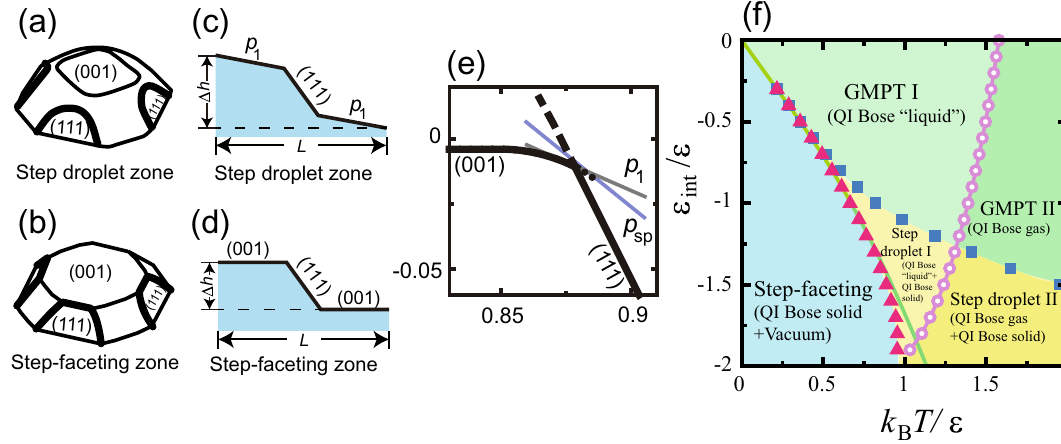
Figure 1. ( a ) and ( b ) Illustrations of perspective view of ECS (Andreev’s free energy) for step drop and step- faceting zones, respectively. Thin lines: facet edges without surface-slope p jumping. Thick lines: sharp edges of facets with p jumps (first-order shape transition 8,18 ). ( c ) and ( d ) Side views of inclined surfaces at equilibrium � h / L with based on results in Refs. 18 and 21. The slope p in the Monte Carlo method corresponds to p = (cid:31) h N step a . ( e ) Cross section of ECS at 0.9 and 001 111 – plane in step droplet zone with ε int /ε = = − (cid:31) (cid:30) (cid:31) (cid:30) k B T /ε 0.63 . The surface slope p at η is the slope of the tangential plane at η . p 1 represents the slope of the tilted = surface at the coexistent point. p sp represents the slope of the surface at the spinodal point of the metastable surface. ( f ) ε int - T faceting diagram 19,22 . The red triangles indicate T f ,2 values. The blue squares indicate T f ,1 ( 001 ) values. The pink circles indicate the roughening transition temperatures for the (001) surface T R . The green line is a zone-boundary line calculated by the 2D Ising model. The values for all the symbols were calculated using the PWFRG method. For definitions of the terms QI Bose solid, QI Bose liquid and QI Bose gas, please refer to Ref. 19 . This figure is taken from Ref. 19